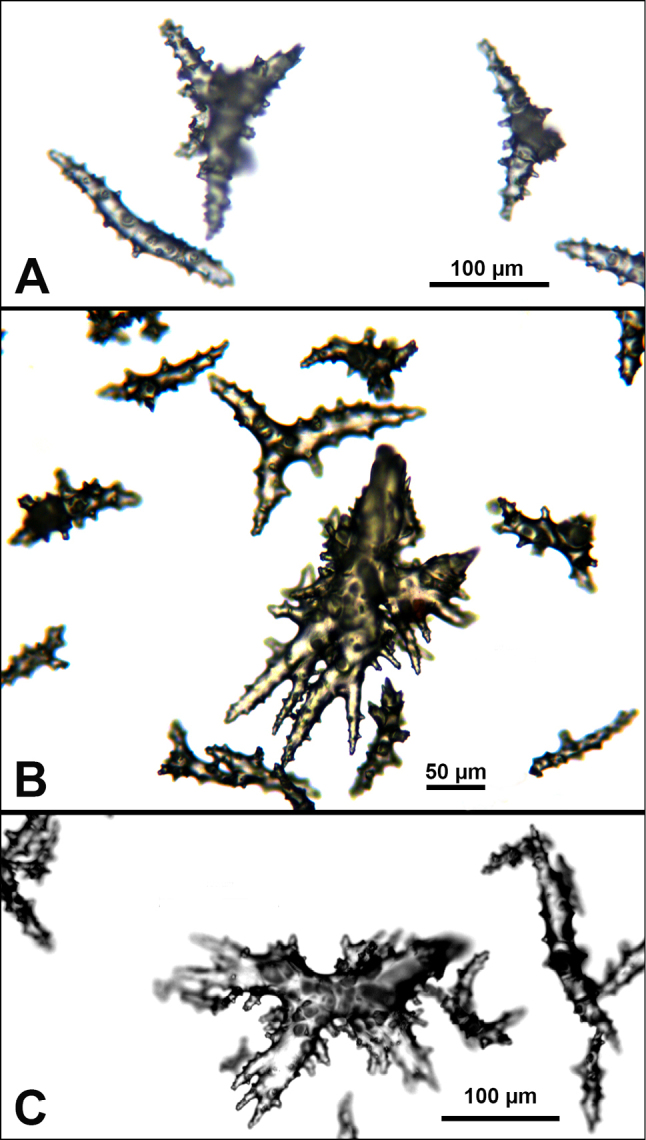
Placogorgia species A. SBMNH 422970, Light microscopy arrays, 10× magnification. A Some of the more unusually shaped sclerites B–C Several highly ornamented and distinctive sclerites. Crutch form ~80 µm tall, thin spindles measure in the range of 150–191 µm in length, larger, thicker spindles are ~250 µm long, with unusual forms, such as B, the tall, spikey sclerite measuring some 300–350 µm tall and that appearing as a very large quadriradiate (C) measuring 280 µm across.